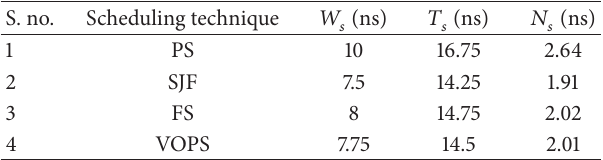
VOPS algorithm are simulated on different task sets having the random values of burst time and static priority and the average waiting time, average turnaround time, and average normalized turnaround time for each task set are calculated. For accuracy VOPS algorithm is compared for all task sets with other algorithms such as priority scheduling (PS), shortest job first (SJF), and fuzzy based priority schedul- ing